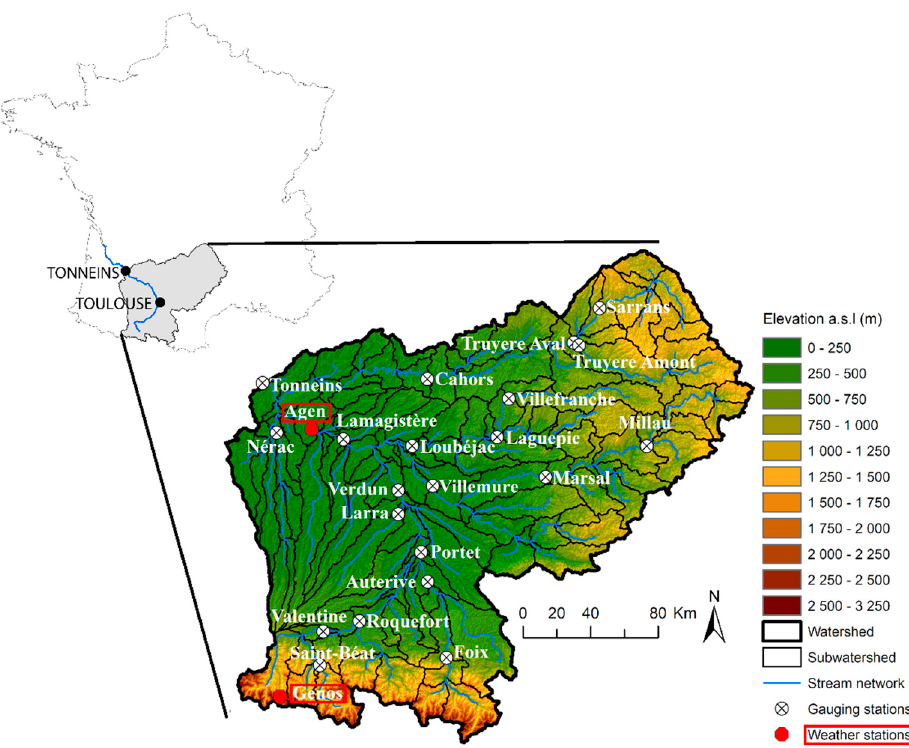
Figure 1. Garonne Figure 1. Garonne watershed.